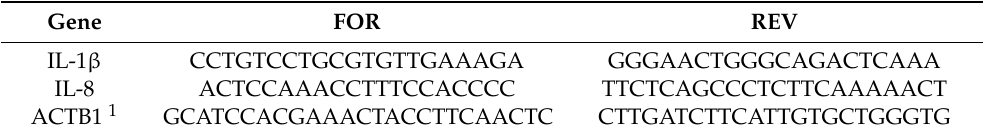
Table 1. Primers sequences for RT-PCR.